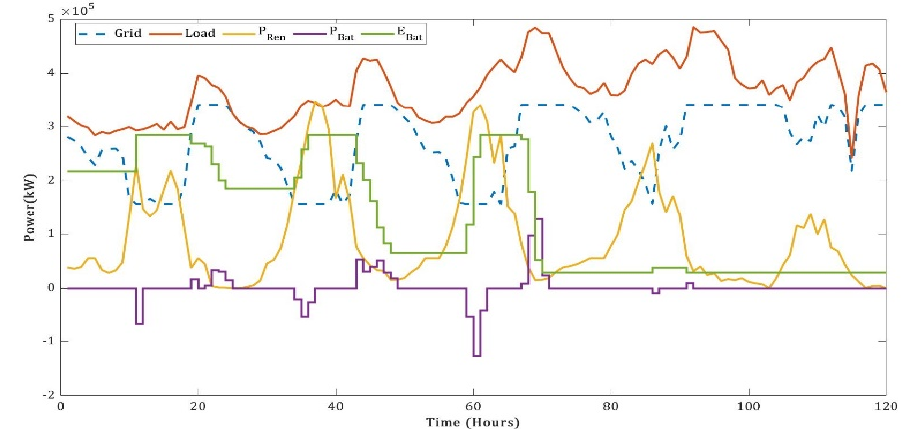
Figure 14. Power distribution with ALA-QPSO for the minimum LPSP for 21–26 June.